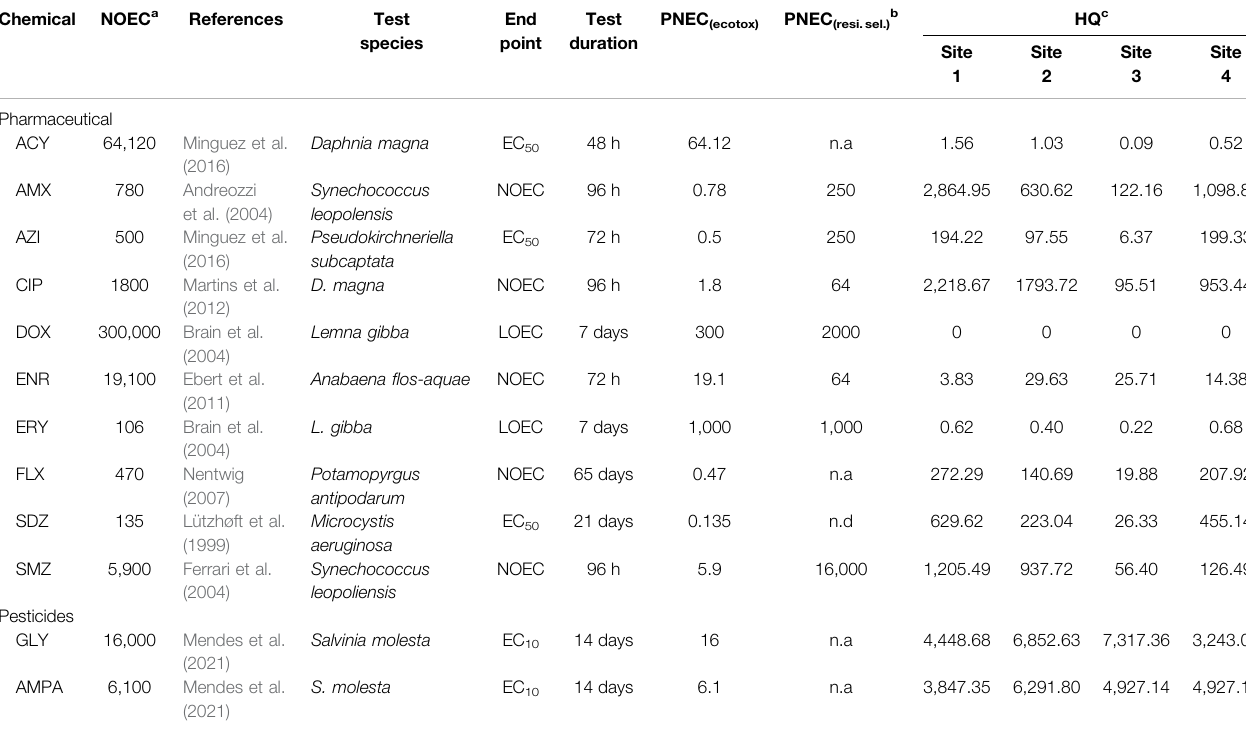
TABLE 3| No-observedeffect concentration (NOEC),thepredicted noeffectconcentrationbasedonecotoxicologicaldata[PNEC (ecotox) ],predictednoeffectconcentration for antibiotic-resistance selection [PNEC (resi. sel.) ] and hazard quotient (HQ) (in ngl − 1